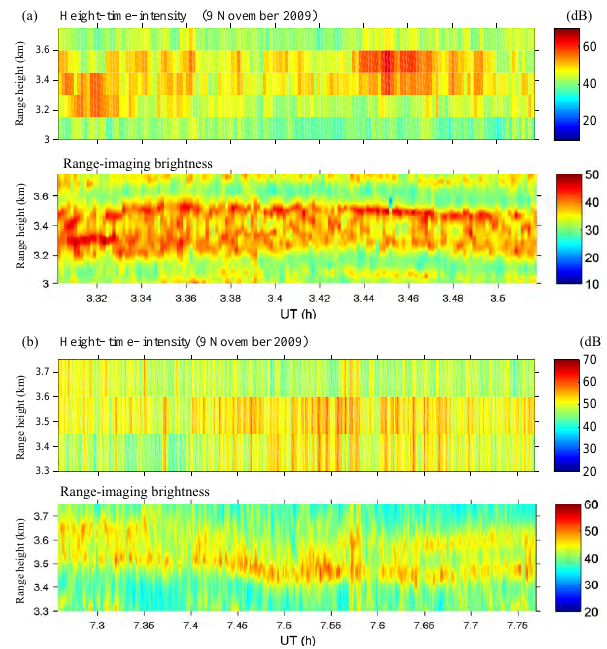
Figure 7: Two types of double-layer structures observed on 9 November 2009. In (a, b) Figure 8. Two types of double-layer structures observed on 9 both, the upper and lower panels show, respectively, height-time intensity and November 2009. In (a, b) both the upper and lower panels show, RIM-produced brightness. respectively, height–time–intensity and RIM-produced